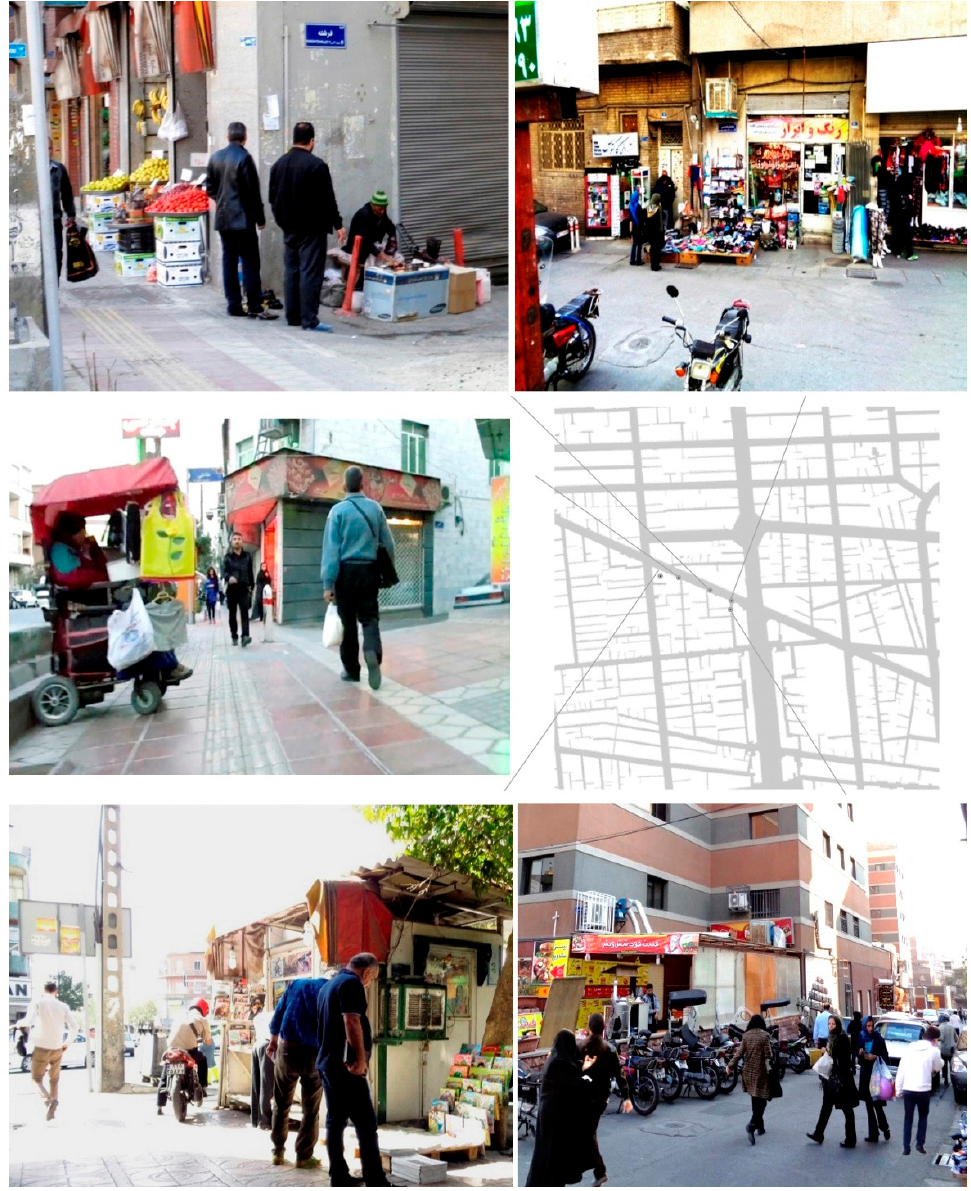
Figure 7. Stationary activities. The West: Navab. Photos: Nastaran Peimani.